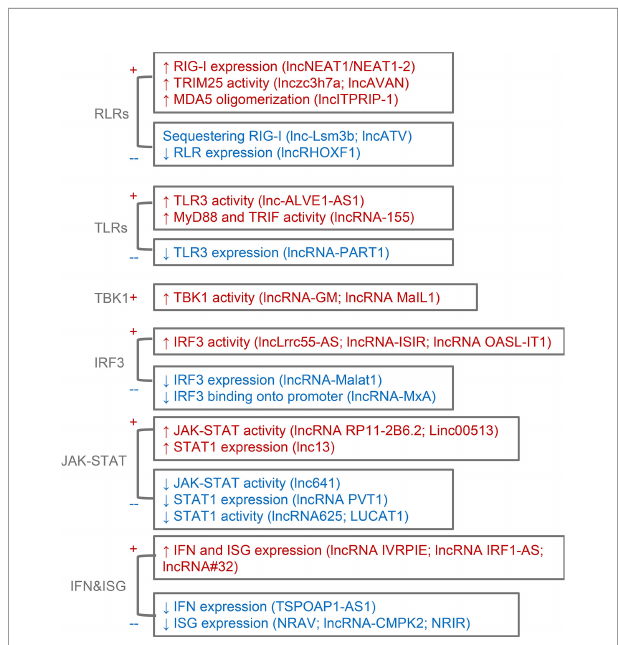
FIGURE 2 | Brief summary of lncRNAs regulating IFN signaling. Based on proteins and events order, lncRNAs affecting RLRs, TLRs, TBK1, IRF3, JAK- STAT axis, IFN, and ISG expression are discussed. +, positive regulation. -, negative